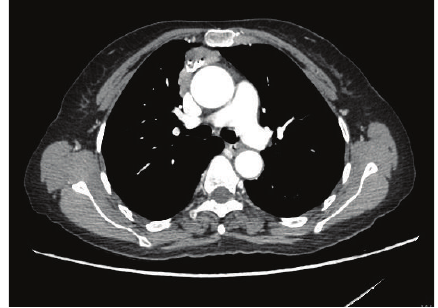
Figure 2: Chest CT showing anterior mediastinal mass with calcification and regional invasion consistent with athymic